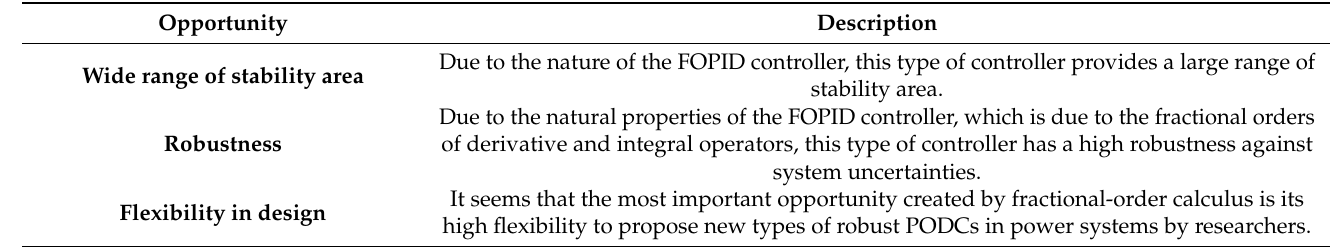
Table 10. Opportunities and benefits of the FOPID controller for LFO mitigation in power systems. Opportunity Description Wide range of stability area